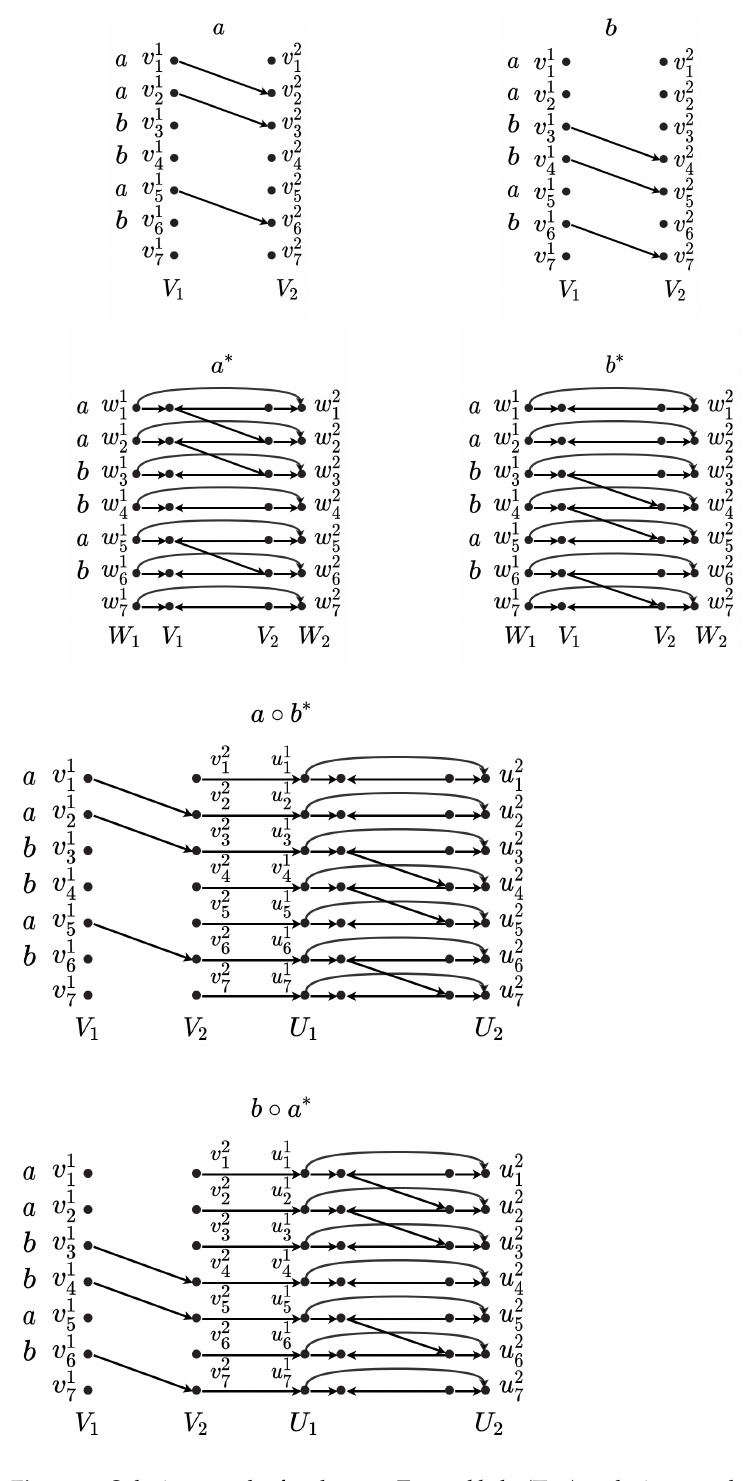
Figure 2. Solution graphs for the text T = aabbab . ( Top ): solution graphs for regular expressions a and b . Second from top: solution graphs for the regular expressions a ∗ and b ∗ . Second from the bottom: solution graph for a ◦ b ∗ . ( Bottom ): solution graph for b ◦ a ∗